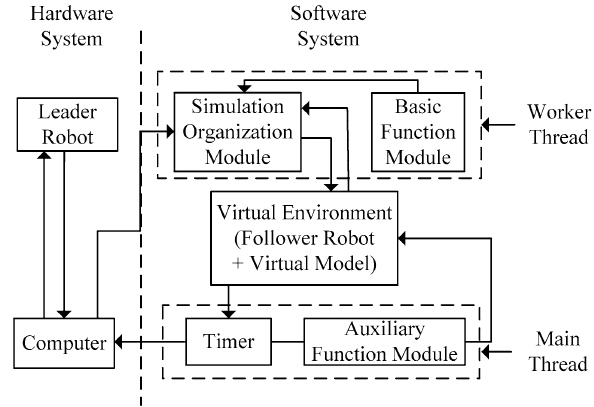
Figure 7. Schematic diagram of the virtual simulation platform.